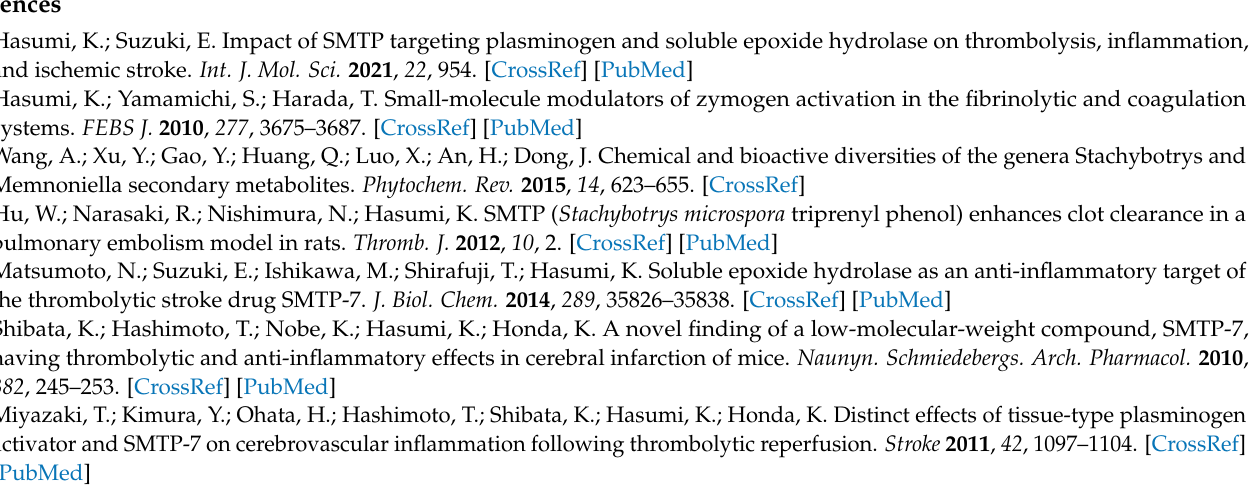
Table S3: Summary of the purification of pri-SMTP oxidase; Table S4: Parameters for the peptide mass fragment analysis; Table S5: Supporting